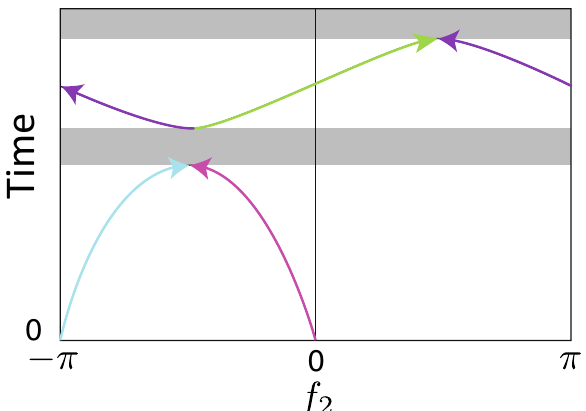
Figure 2. Schematic of viable speed-controlled trajectories in the f 2 − t space. Each viable speed-controlled trajectory is represented by a different colored curve. The arrows indicate the direction of time evolution of the solutions, f 2 ( t ) . At t = 0 , there are two trivial solutions of β FF ( t , f 2 ) = 0 , f 2 = 0 and − π because α( 0 ) = 1 . In the two time domains marked by gray color, there exists no realizable wave function with the form of Eq.